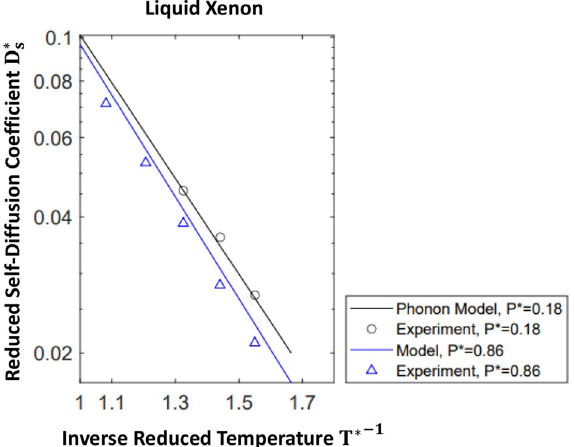
Figure 5. Self-diffusion coefficient for liquid Xenon. See the caption to Fig. 3 for a description of the phonon model of self-diffusion. The experimental self-diffusion data was reported in 38 ; experimental uncertainty was estimated to be less than 5 % 38,61 .